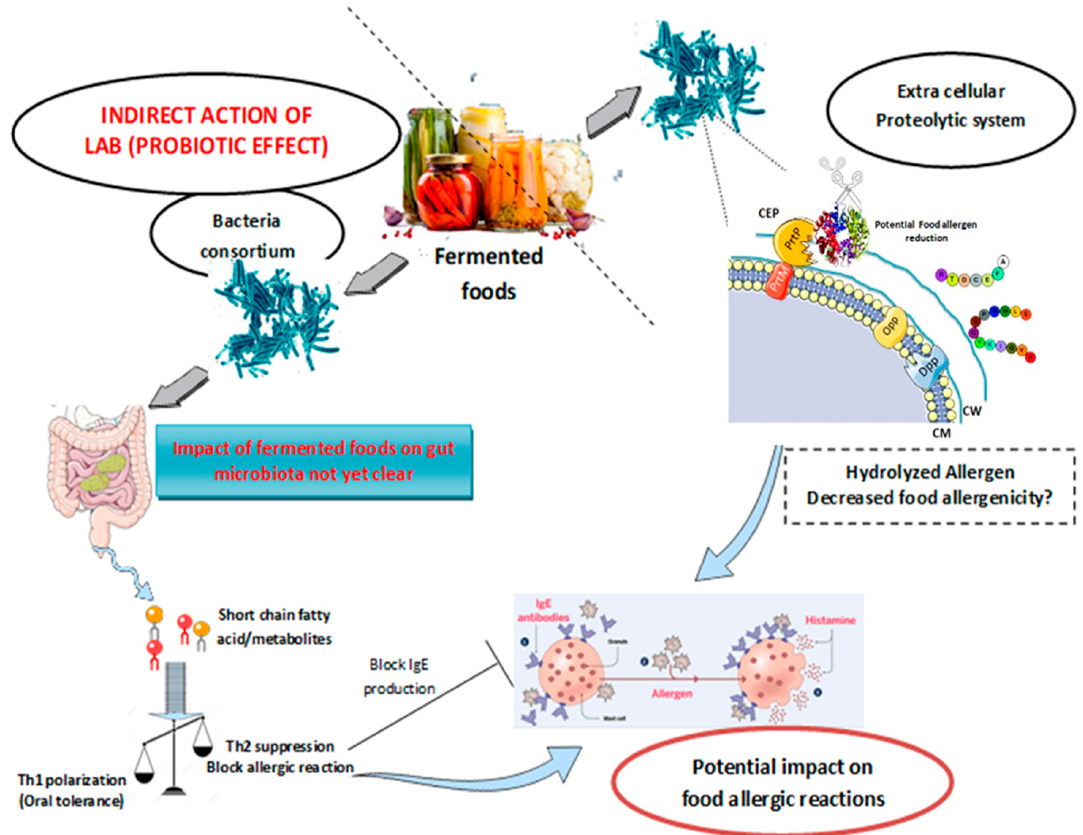
Figure 2. Potential direct and indirect effects of food fermentation by lactic acid bacteria (LAB) on food allergy modulation. The direct effects are represented by the degradation of the allergen by the LAB proteolytic system. The indirect effects are related to the probiotics properties of the fermented foods that could modulate the intestinal microbiota and then prevent food allergy. CW: cell wall; CEP: cell envelope protein; Dpp: dipeptide permease; Opp: oligopeptide permease; PrtP and PrtM: proteinase production promoters.